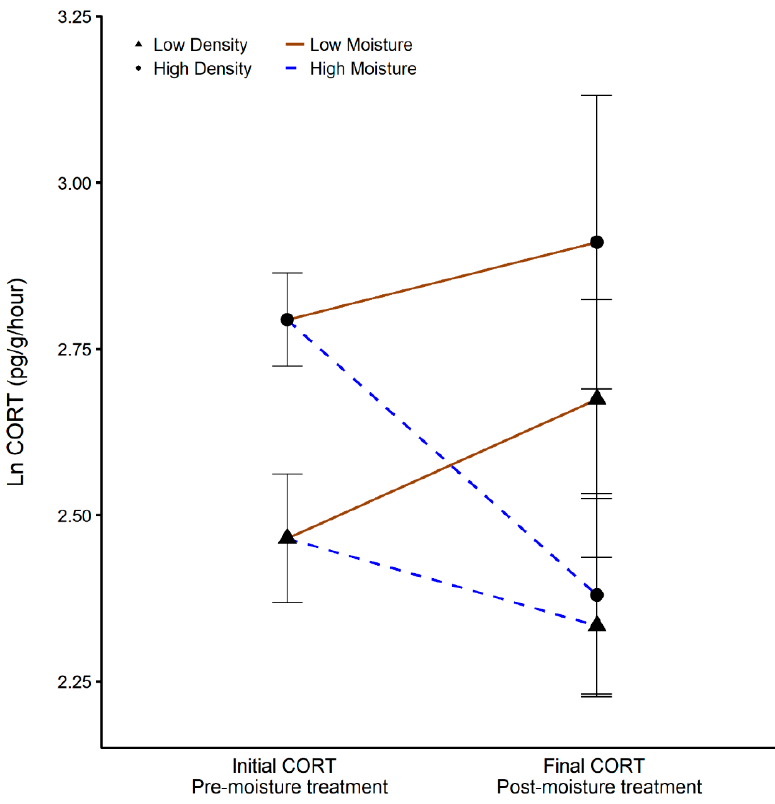
Figure 2. Mean Ln corticosterone (CORT) release rates at two time points ± SE. Triangles ( ▲ ) represent low larval density treatments and circles (•) represent high larval density treatments. Low terrestrial moisture (–– brown, solid line) and high terrestrial moisture (---- dashed, blue line) treatments were applied after the measurement of Initial CORT.